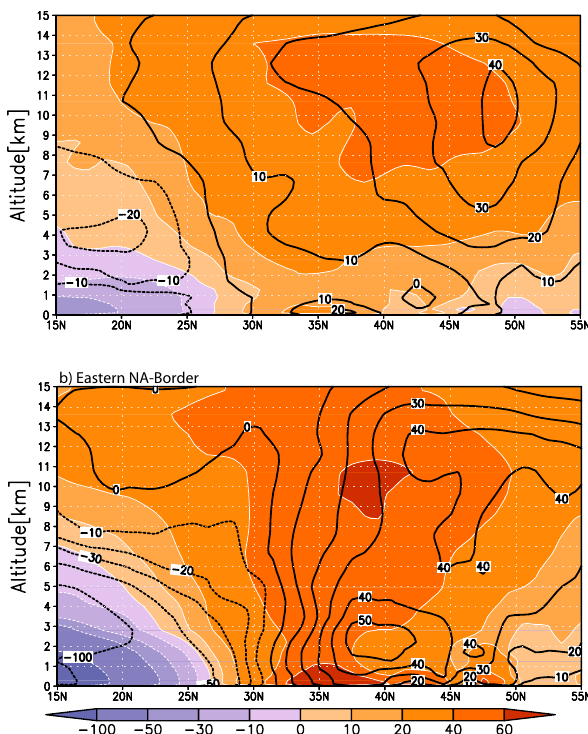
Fig. 3. Vertical sections of aerosol transport fluxes (µgm − 2 s − 1 ) at (a) the western and (b) eastern borders of NA- region seasonally averaged in winter (filled contours) and summer (contour lines) over